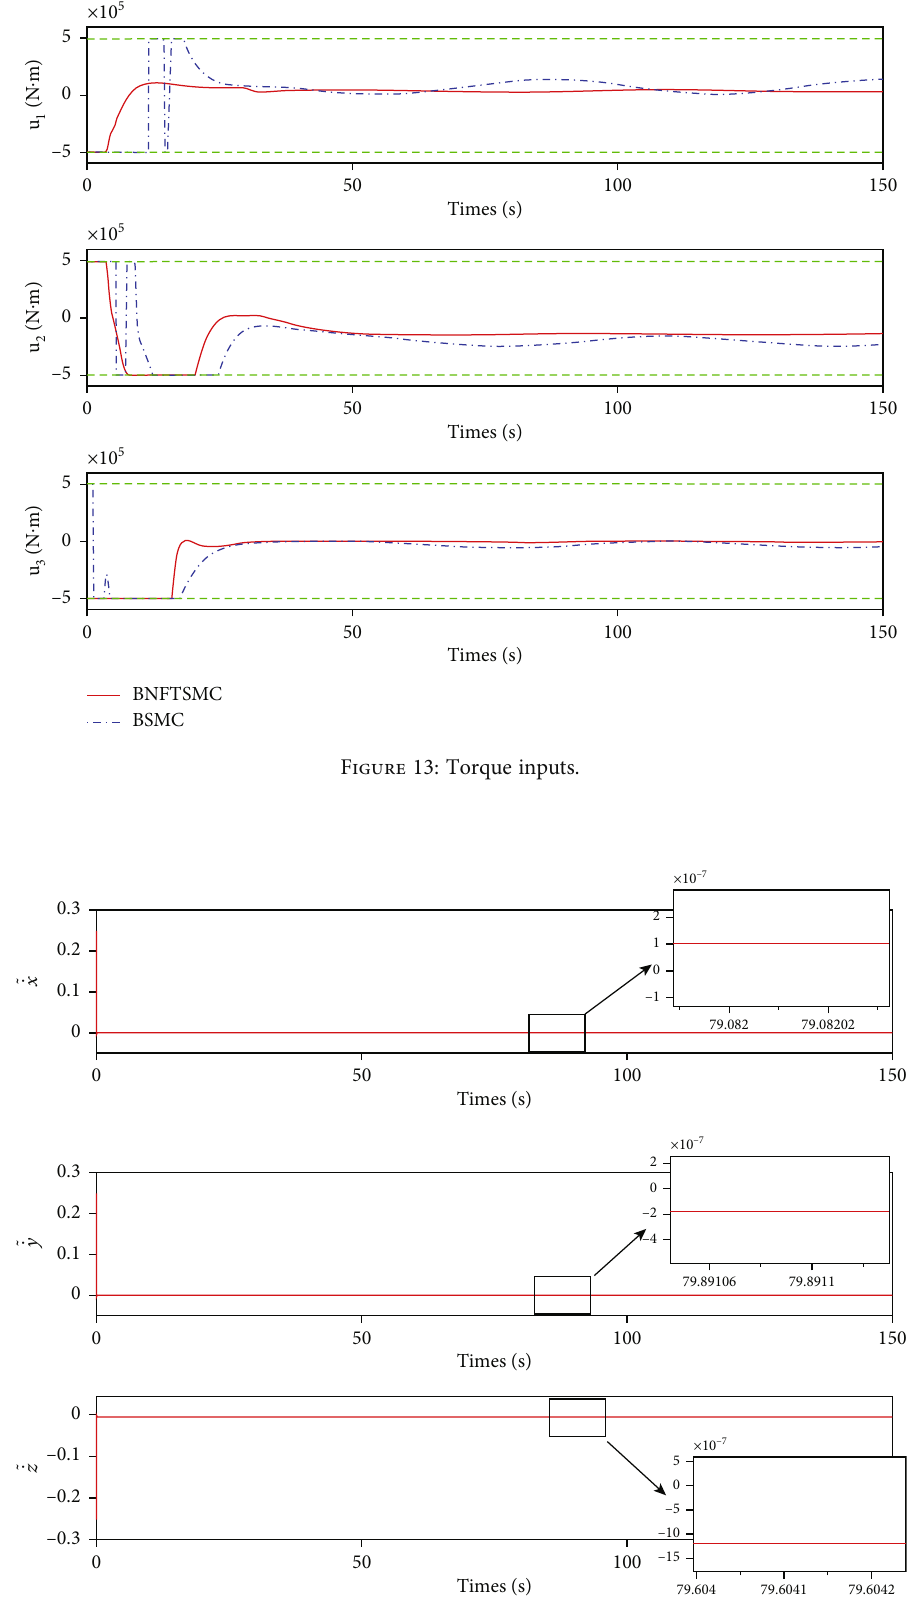
Figure 14: Observation errors of ESO in position